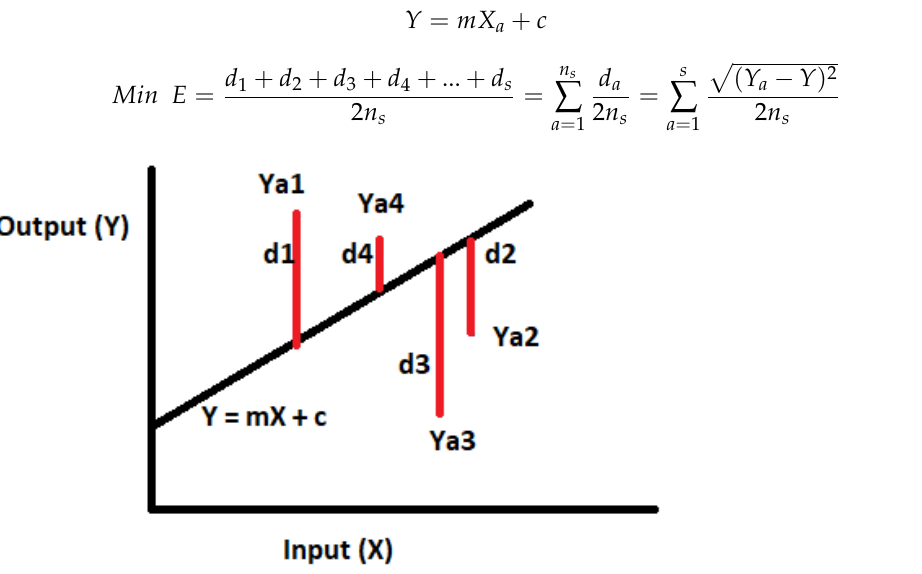
Figure 2. Distance between actual output (Ya) and predicted output